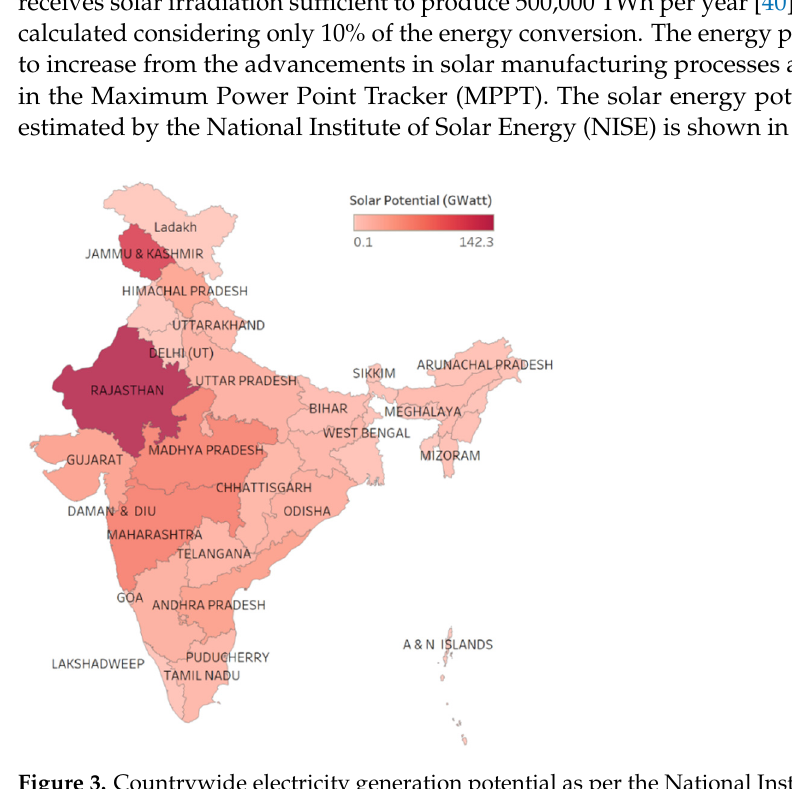
Figure 3. Countrywide electricity generation potential as per the National Institute of Solar Energy (NISE).